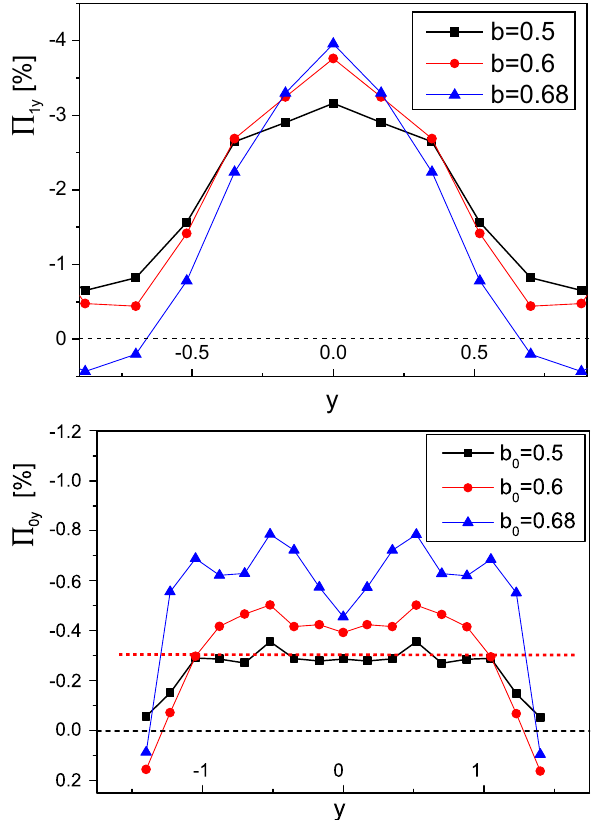
Fig. 5 The first term of the polarization (upper panel), and the global polarization (lower panel) as a function of rapidity at different impact parameter ratios. The red dashed line in the lower panel figure is a rough approximation of the experimental data